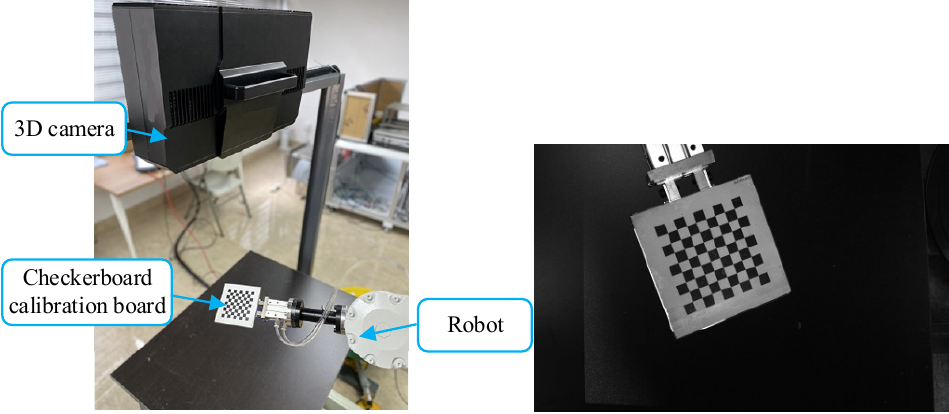
Figure 13. Hand–eye calibration data collection. The calibration board was installed to the end of the robot, and the image of the calibration board was collected through the camera.